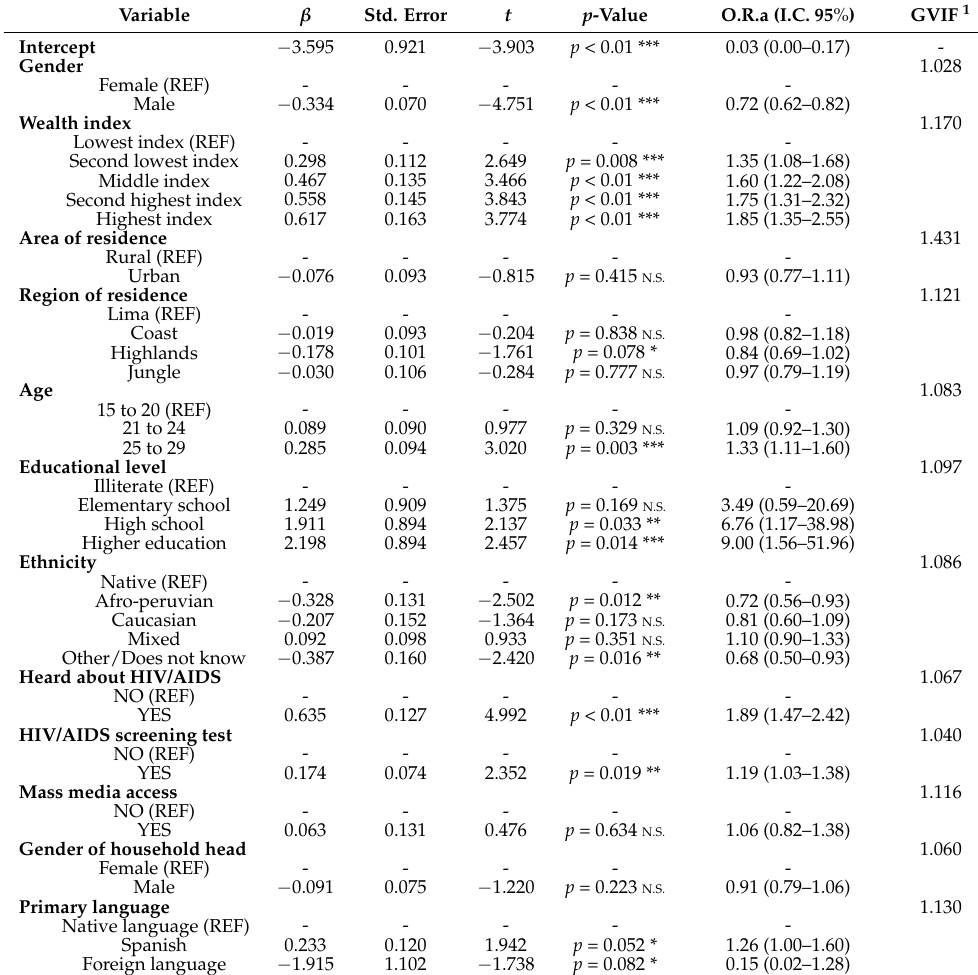
Table 4. Results of the multivariate analysis of the association between socio-demographic, economic and health factors and knowledge about